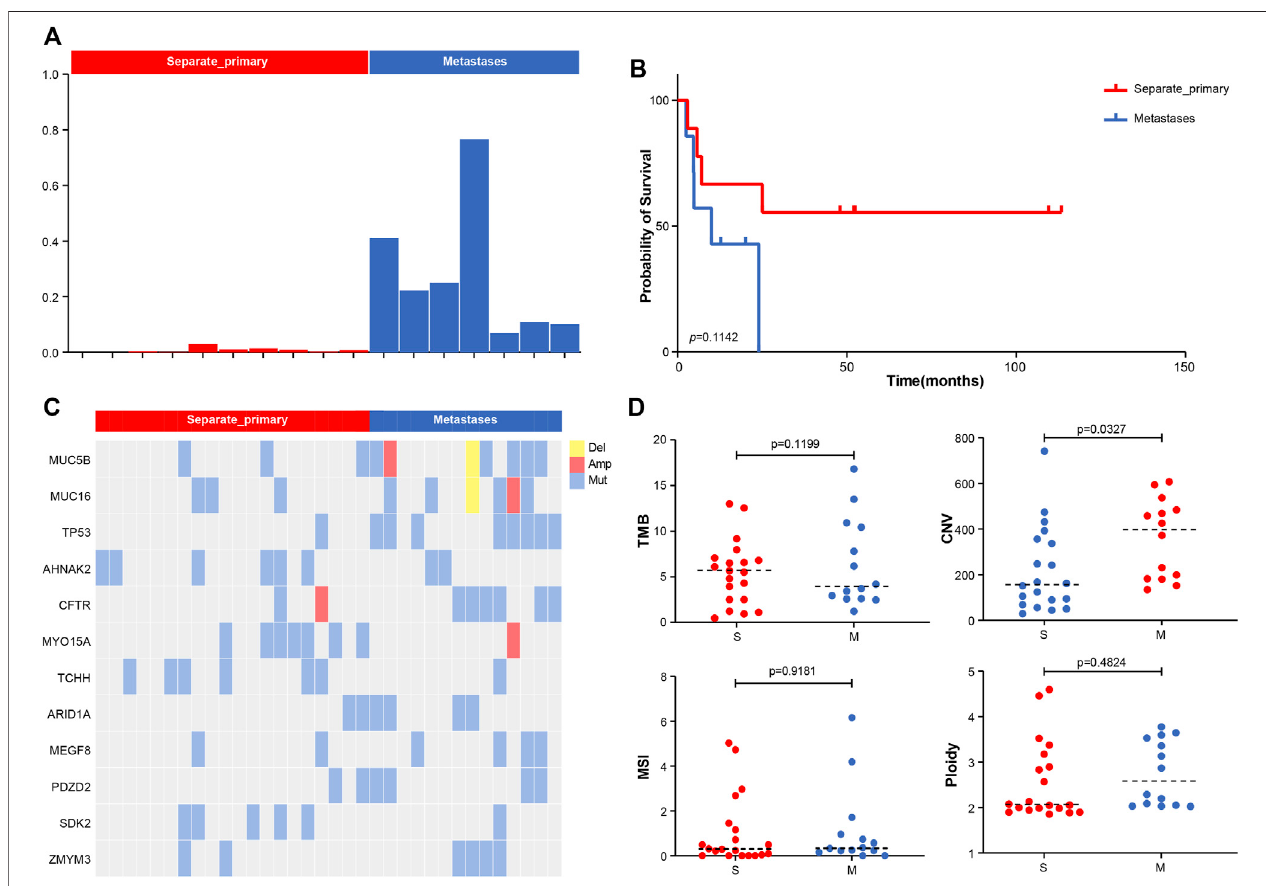
FIGURE 2 | (A) Molecular typing strategy of two cancer subtypes. (B) Associations between cancer types and OS. (C) Comparison of the prevalence of altered genes between two cancer subtypes. (D) Comparison of TMB, CNV, MSI, and Ploidy between two cancer subtypes.